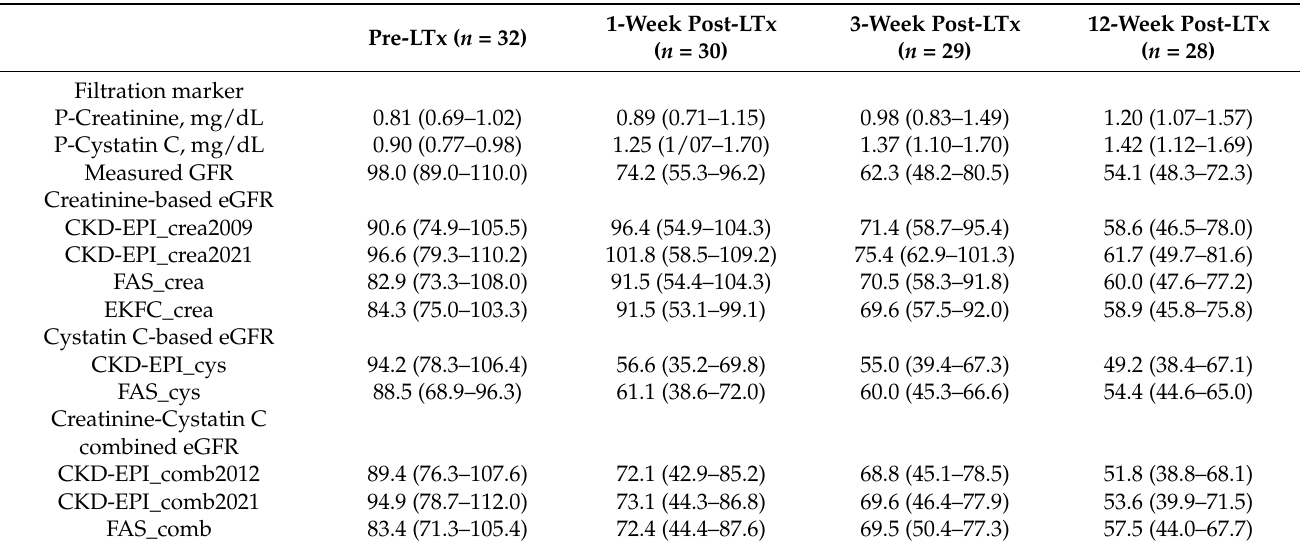
Table 2. Median (IQR) filtration marker concentration and glomerular filtration rate (mL/min/1.73 m 2 ) at each timepoint.